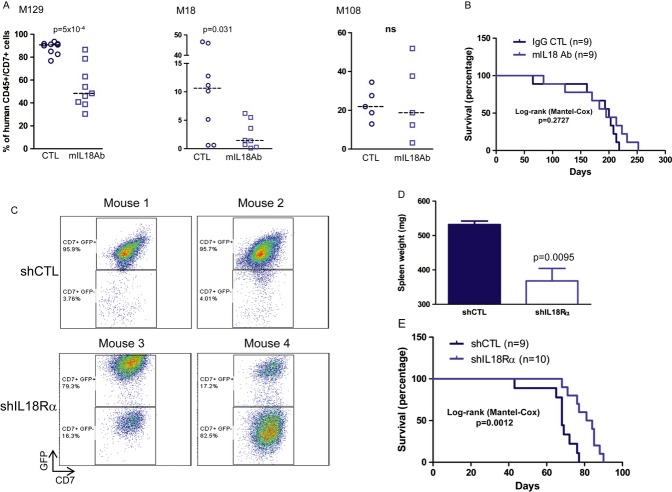
Interfering with IL-18 activity delays leukaemia progression in xenografted miceProportion of human leukaemic blasts (CD45+CD7+ cells using anti-human CD45 and CD7 antibodies) in the bone marrow of NSG mice at week 6 after intravenous injection of 0.5–5 × 103 M129 (left panel), M18 (middle panel) or M108 (right panel) T-cell acute lymphoblastic leukaemia (T-ALL) cells that were pre-treated in vitro with mIL-18Ab or with isotype control Ab (CTL) for 2 weeks.Survival curves of NSG mice transplanted with M129 T-ALL cells and shown in (A).GFP expression in CD45+CD7+ leukaemic blasts recovered from NSG mice transplanted with M105 T-ALL cells that were transduced with shIL-18Rα/GFP (n = 10 mice) or shCTL/GFP vectors (n = 9 mice). Shown are results of four representative animals.After euthanasia, spleens were recovered and weighed (mean ± s.d. of four mice transplanted with shCTL M105 T-ALL and six animals injected with shIL-18Rα M105 T-ALL).Survival curves of mice transplanted with 5 × 103 shCTL or shIL-18Rα M105 T-ALL GFP-positive cells.